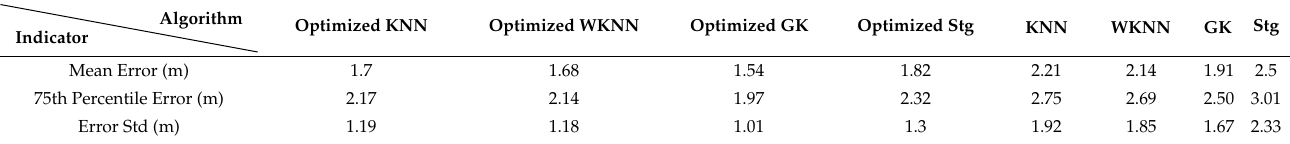
Table 4. Error of optimized Wi-Fi fingerprint-matching